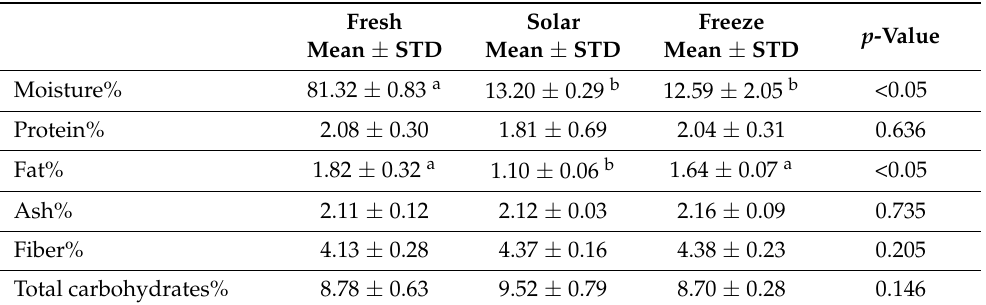
Different superscript letters in a row are significantly different ( p ≤ 0.05). Table 3. Proximate chemical composition percentages based on dry basis for fresh, solar, and freeze- dried O. syriacum . Fresh